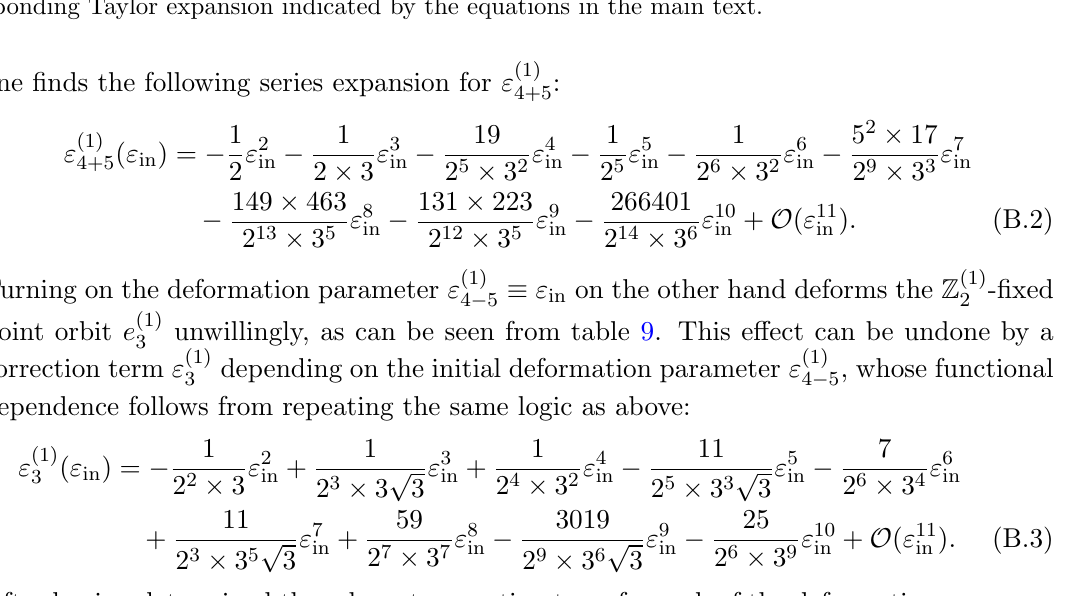
deformation parameters with the corre- 2